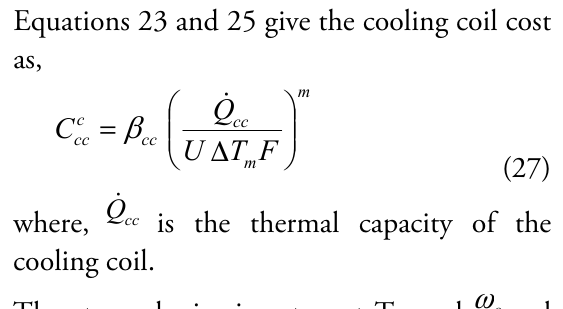
Fig. 2. Temperature levels for the three working fluids, not to